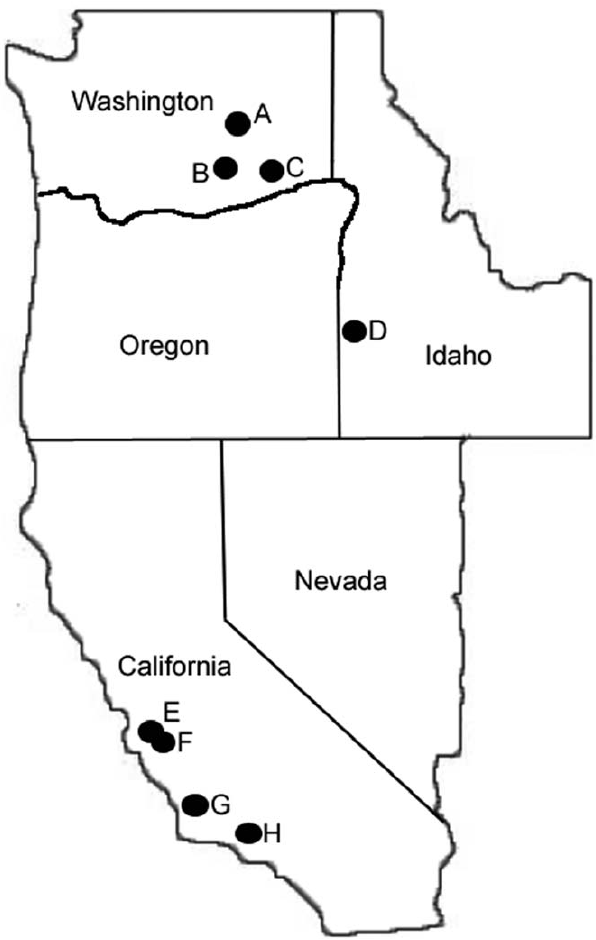
Figure 1. Map of collection sites in Washington, California, and Idaho. A: Othello, WA. B: Prosser, WA. C: Touchet, WA. D: Parma, ID. E: Watsonville, CA. F: Prunedale, CA. G: Santa Maria, CA. H: Camarillo, CA.